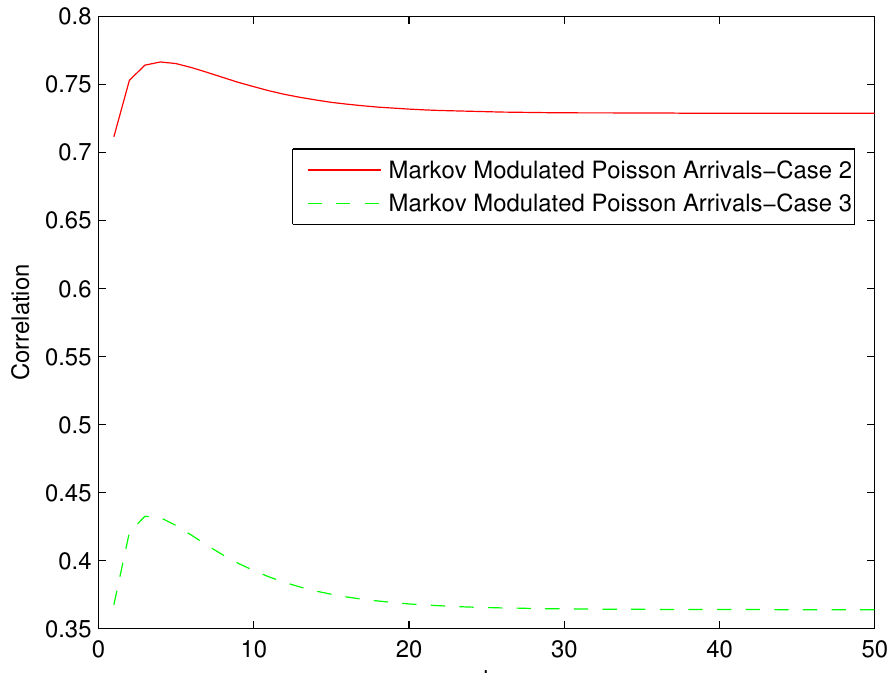
Figure 2. Correlation between Incurred But Not Reported (IBNR) and Reported But Not Settled (RBNS)